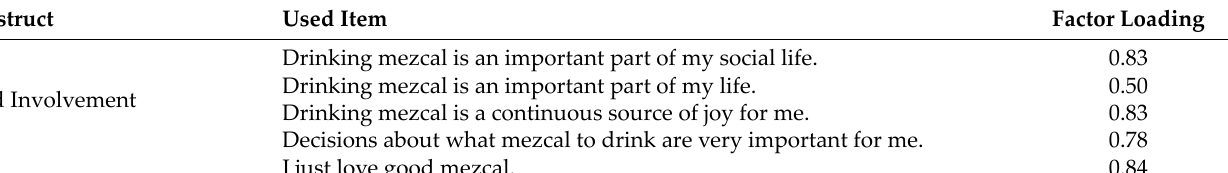
Table 2. Constructs and corresponding items evaluated in the